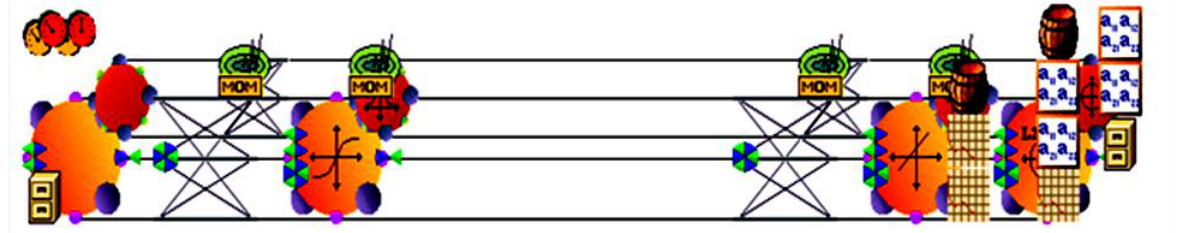
Figure 15. Schematics depicting the c onstructed Multilayer Perceptron network and the network topology for the hidden input and output layers employing Artificial Neural